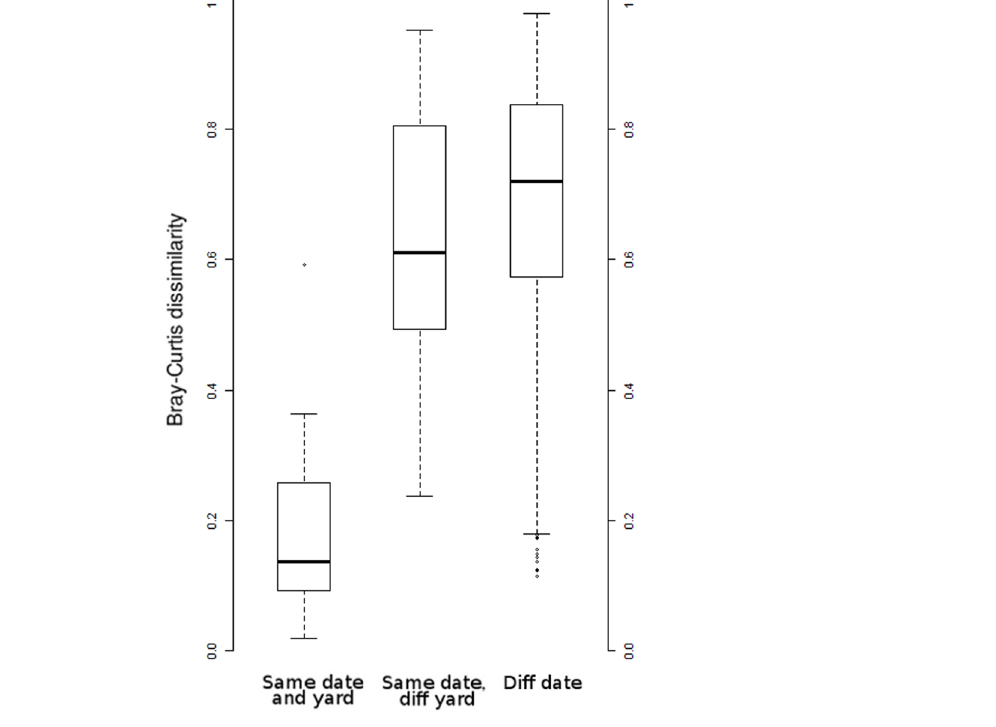
Fig 6. Box plots of pairwise Bray-Curtis dissimilarities computed with Megan v. 5.10.2 [52]. The range of possible values is 0 – 1. Only 2009 samples were compared as relatively few 2010 biological replicates were available and a year-effect on phenology is possible. Samples collected from different hives but from the same date and apiary were more similar than samples collected from different dates and apiaries. This indicates that variation among biological replicates is lower than spatial or temporal variation in